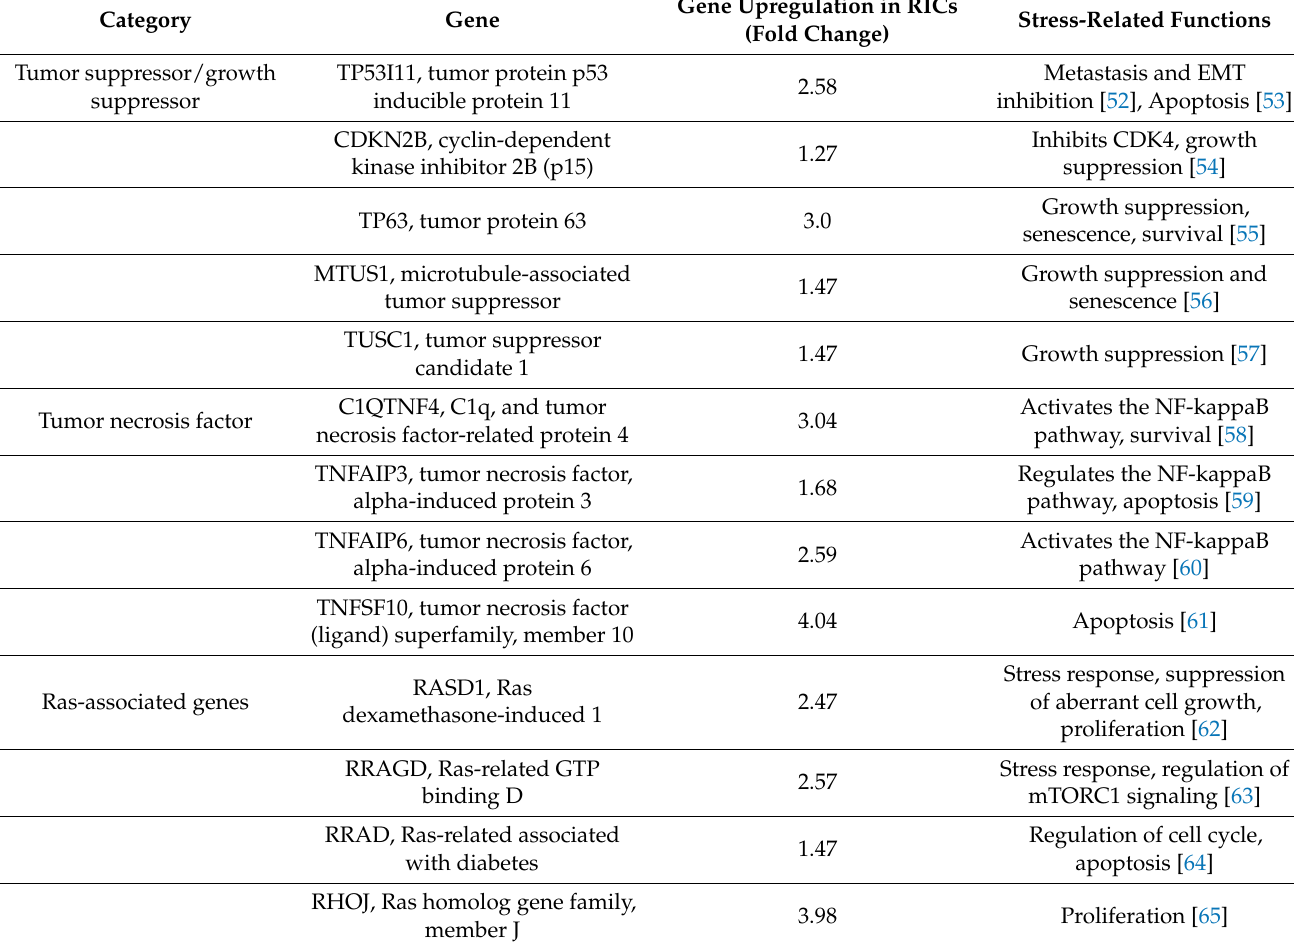
Table 1. Stress-associated genes found to be upregulated in RICs by RNA-seq analysis. Gene expression was compared between day 0 and day 14 after ribosome incorporation [16]. Upregulation cut off value = 1.2 (Fold